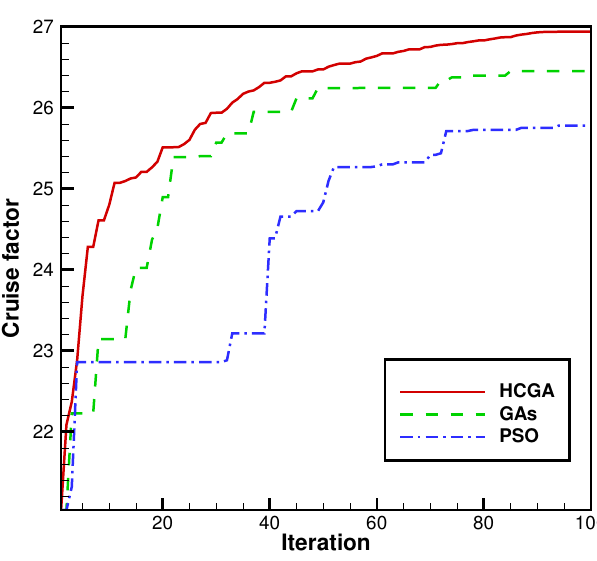
Figure 11. Convergence curves of cruising